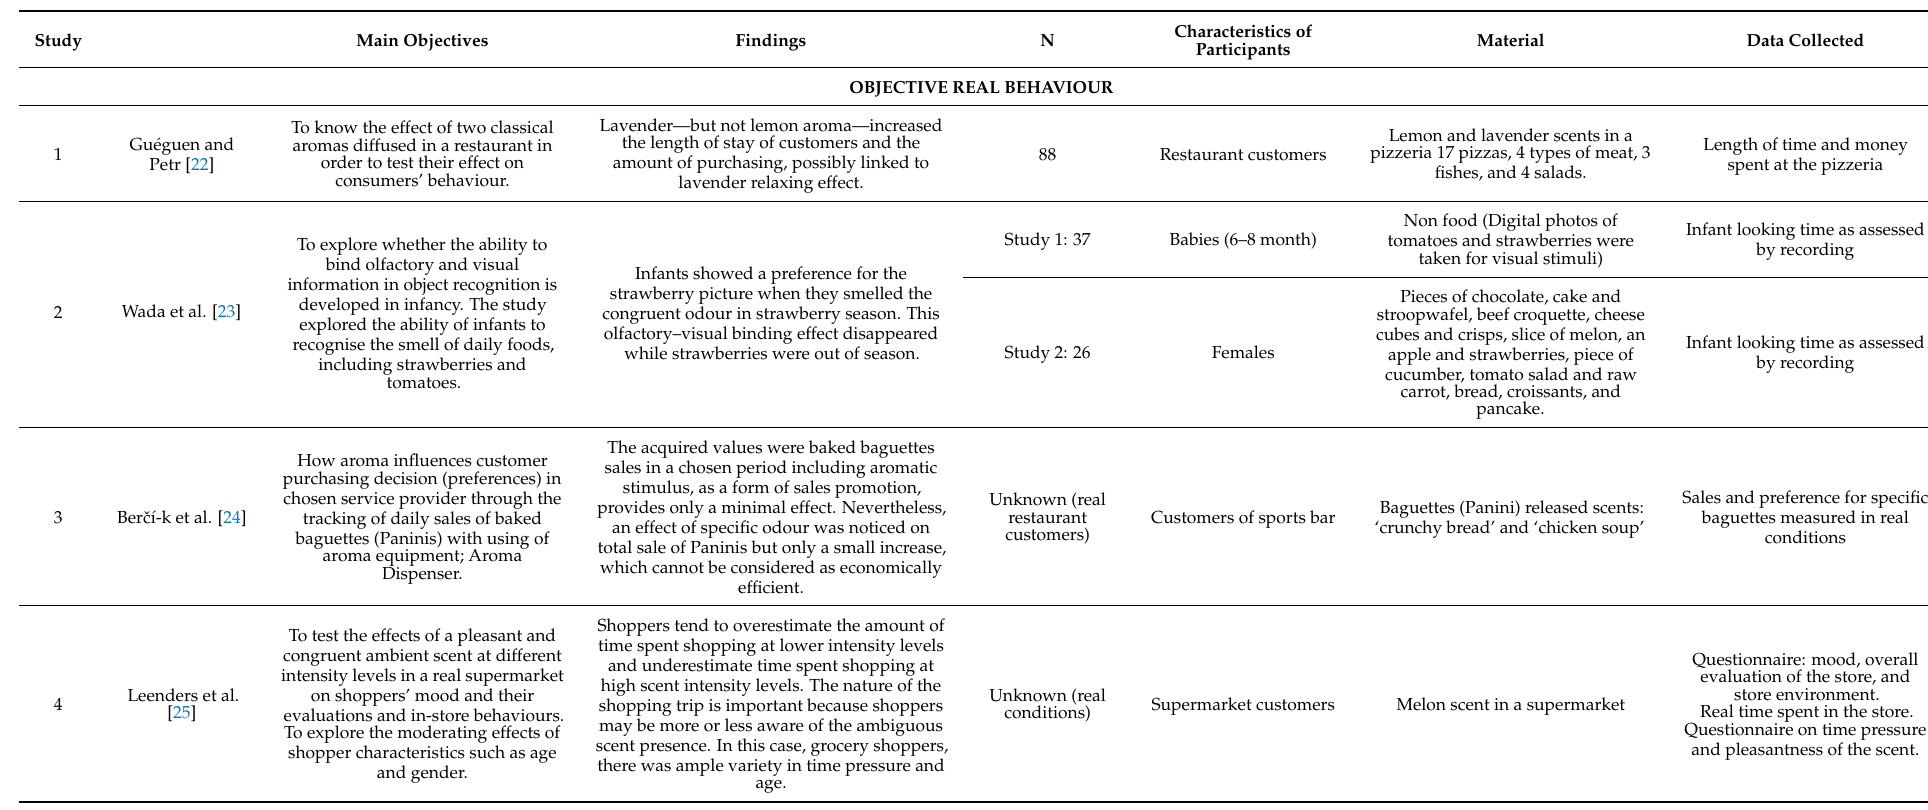
Table 1. Coding of revised manuscripts found linked to neuromarketing and aromachology in restaurants and food establishments, with its objectives and finding of the revised scientific evidence. Basic data on the experiments on reviewed papers: number of participants, characteristics of participants, and food/non-food